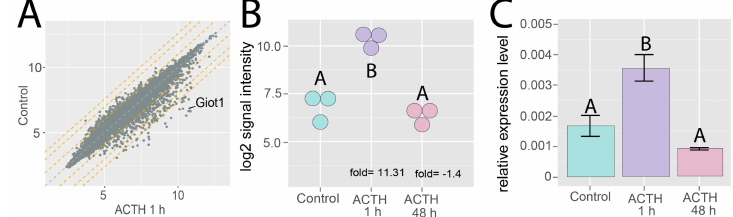
Figure 2. Effect of ACTH (adrenocorticotropic hormone) on Giot1 gene expression in adult male adrenals. Rats were intraperitoneally injected with acute (ACTH 1 h, 5 µ g /rat injected 1h before decapitation) or prolonged quadruple injections of ACTH with 12 h intervals (ACTH 48 h). Control group of rats were injected with physiological saline solution and studied at 60 min post-injection. ( A ) Scatter plot from microarray transcriptome studies of adrenals from control vs 1 h ACTH treatment experimental group. The average expression value of the Giot1 gene is shown. Orange dotted lines denote expression above 2, 4, 6 fold changes; ( B ) data extracted from normalized gene expression dataset of Affymetrix Rat Gene 2.1 ST Array, presented as a dot plot in log2 signal intensity scale. Expression fold change was calculated in relation to control group; ( C ) qPCR validation of microarray results. Bars represent means ± SEM ( n = 3). Statistical analysis of the data was performed by using one-way analysis of variance (ANOVA) followed by Tukey’s honest significant difference test (Tukey’s HSD test). Groups sharing the same letter are not significantly different according to Tukey’s HSD